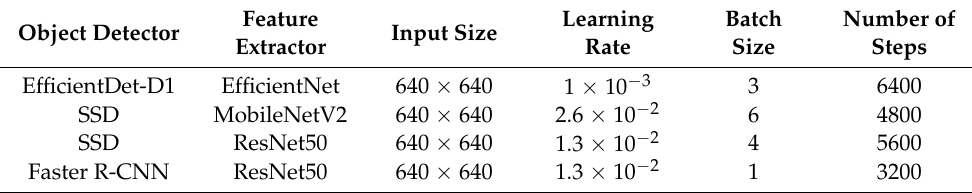
Table 3. Hyperparameter details of each pretrained